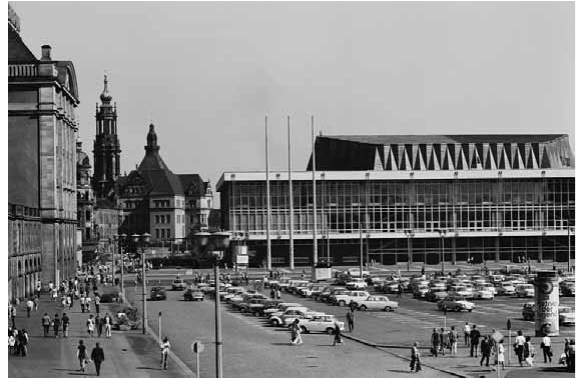
fig. 3. Kulturpalast Dresden . View from the altmarkt, 1973. SluB Dresden / Deutsche fotothek / Hering